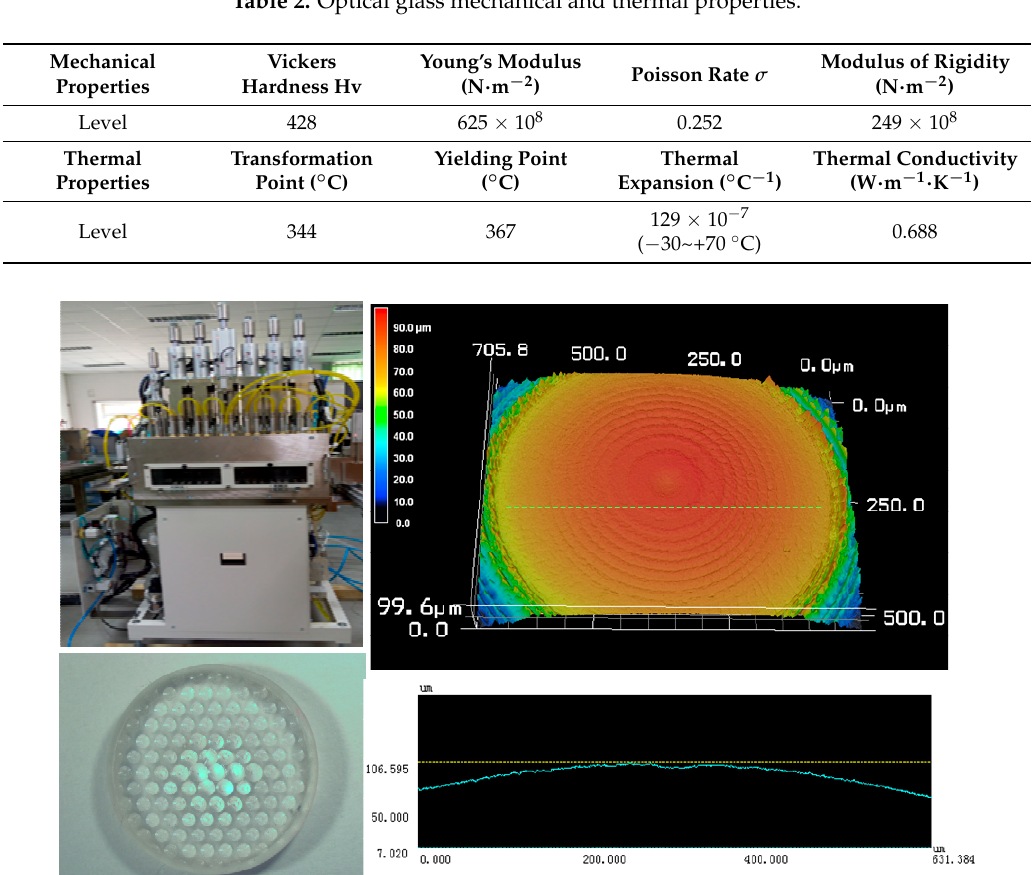
Figure 10. Experimental setup for hot embossing the micro-lens array and the achieved results.